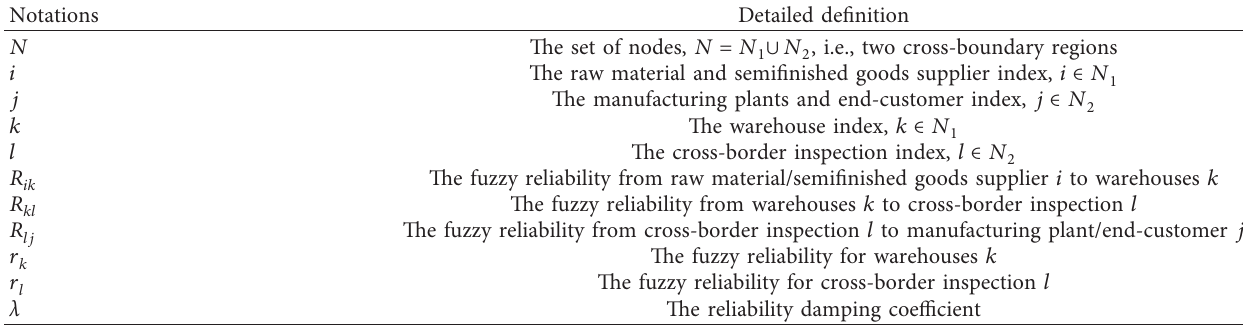
Table 1: Notations in this problem.